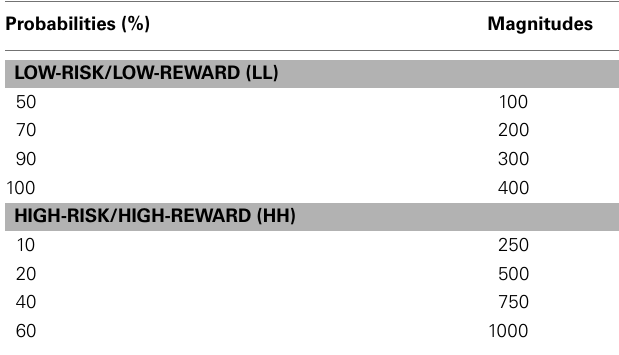
Table 1 | Probability and amount parameters used to generate the list of 96 trials experienced by every